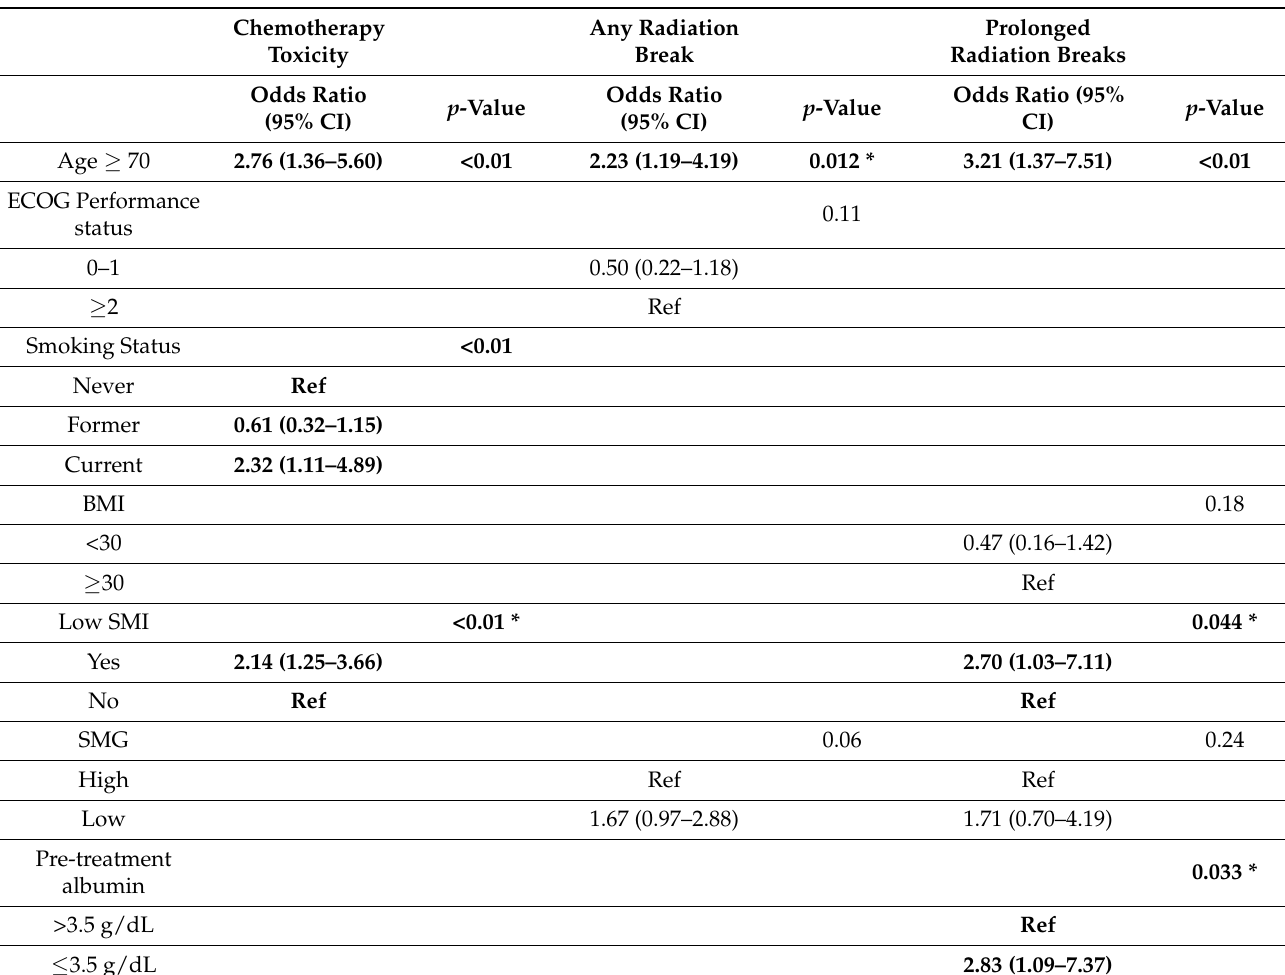
Table 2. Multivariate predictors of chemotherapy and radiation toxicity breaks. * Selected variable identified by random forest method. Bolded variables represent p -value <